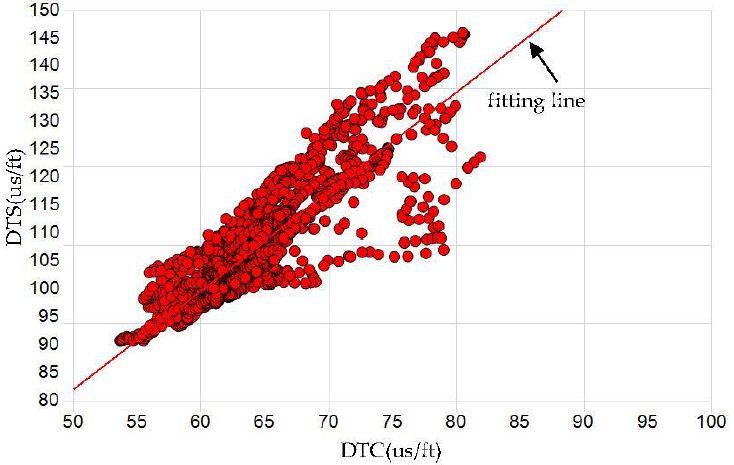
Figure 16. Crossplot of S-sonic and P-sonic and their linear fitting.